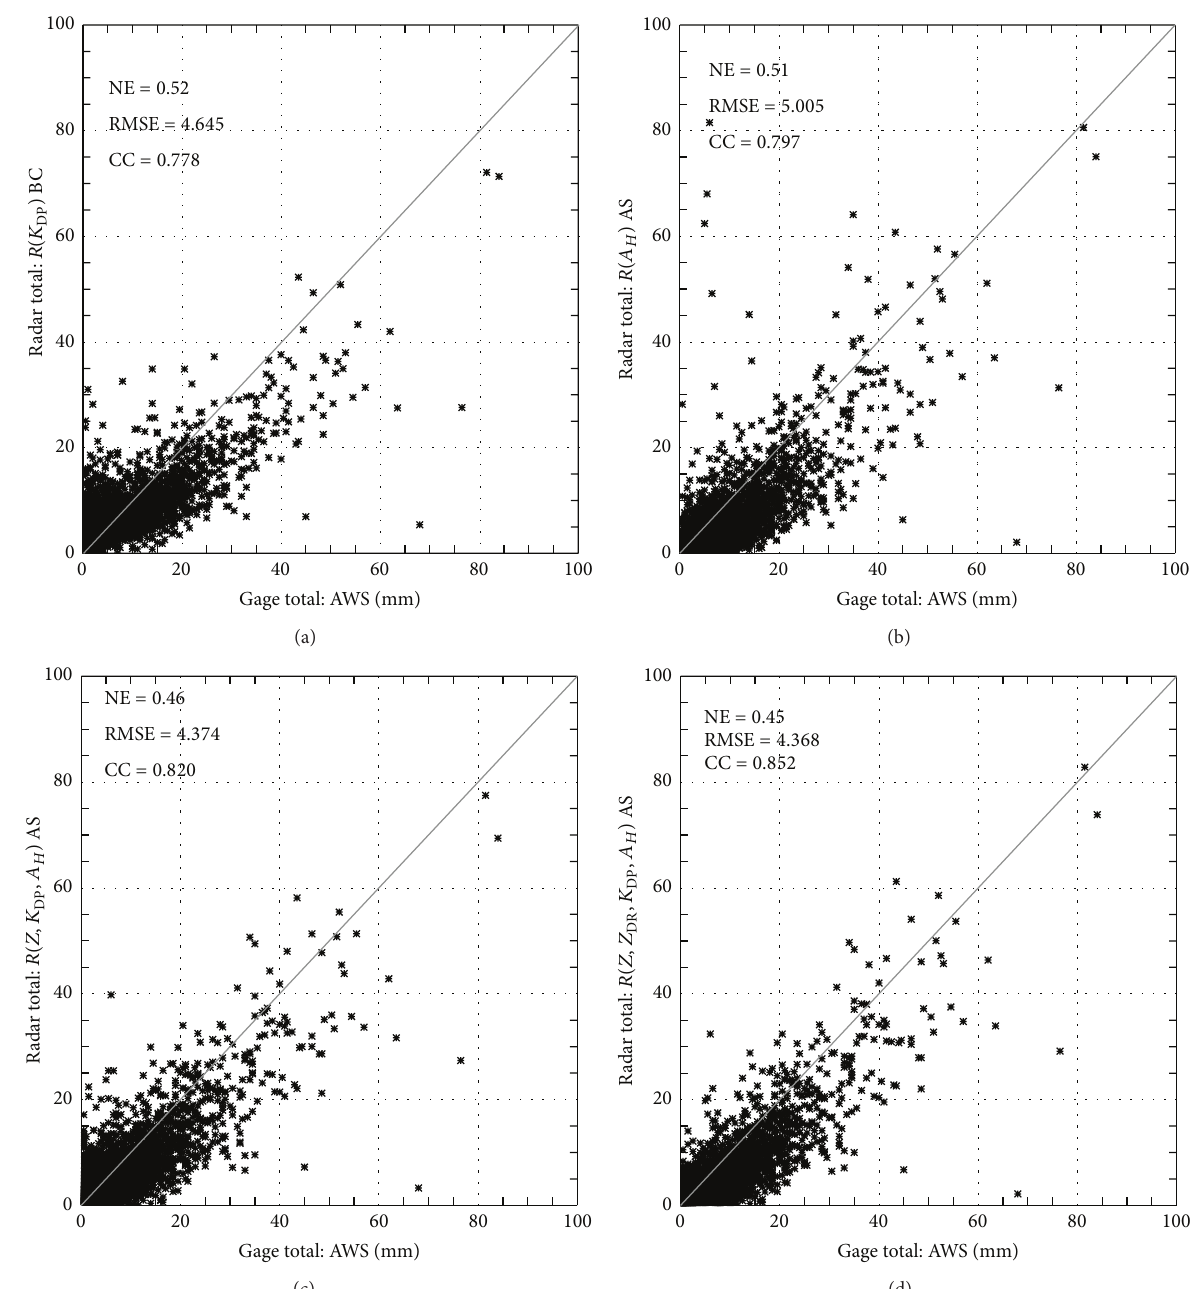
Figure 9: The scatter plot of gage rainfall and 𝑅(𝐾 DP ) , 𝑅(𝐴 𝐻 ) , 𝑅(𝑍,𝐾 DP ,𝐴 𝐻 ) , and 𝑅(𝑍,𝑍 DP , 𝐾 DP , 𝐴 𝐻 ) rainfall for 84 hours.